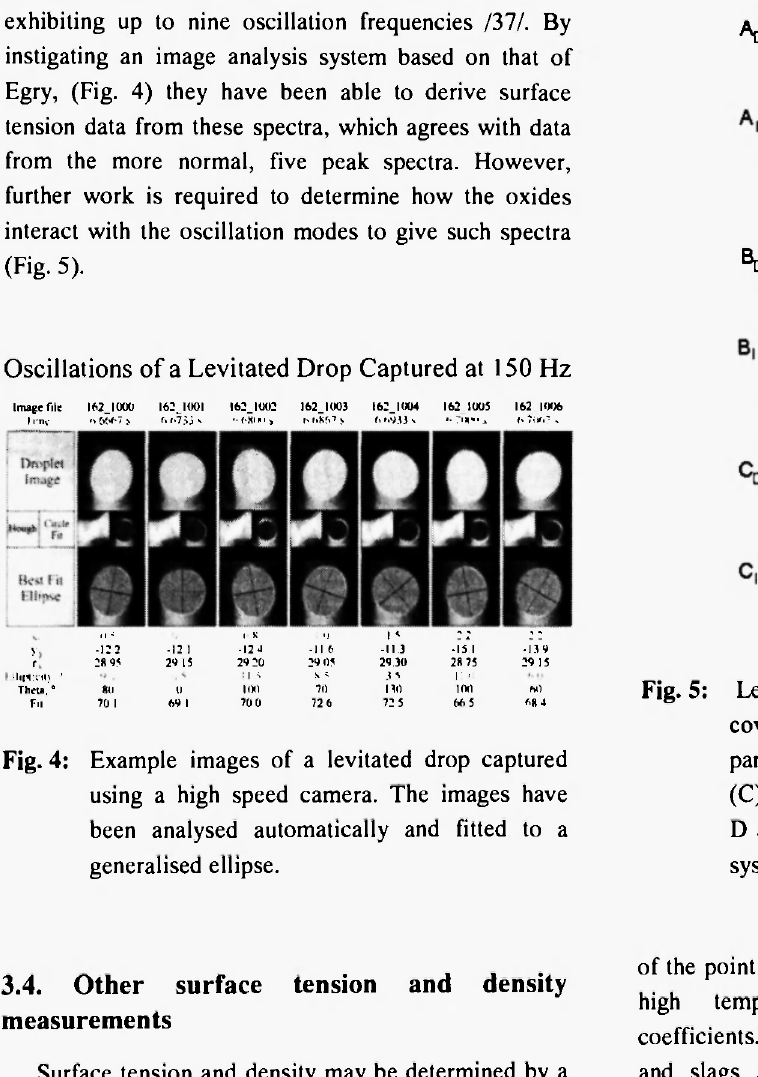
Fig. 4: Example images of a levitated drop captured using a high speed camera. The images have been analysed automatically and fitted to a generalised ellipse.